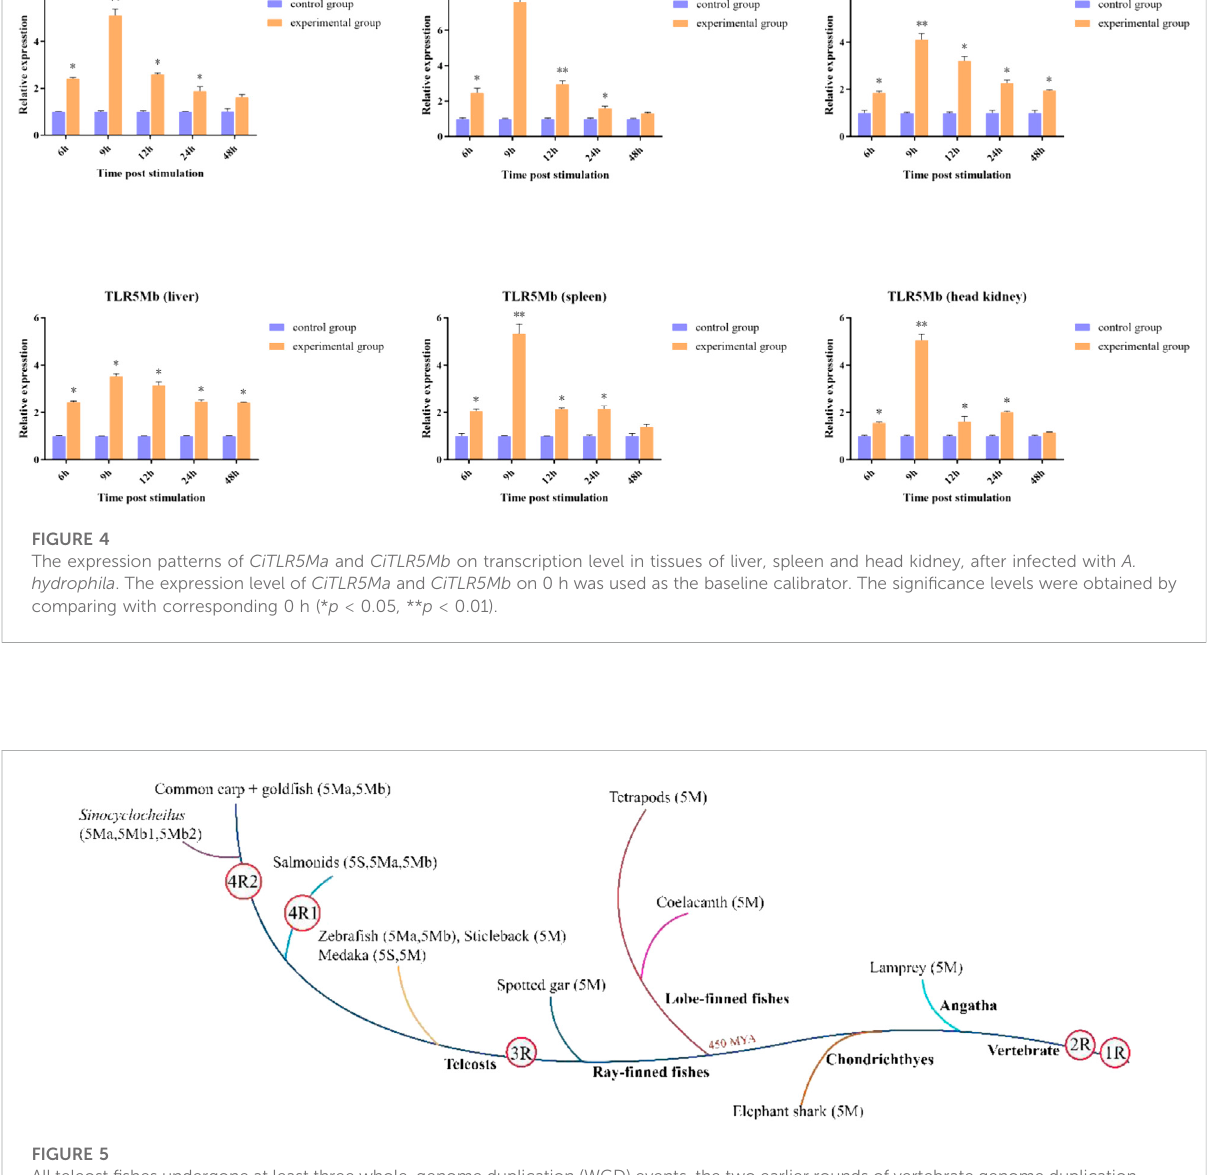
type) demonstrated neofunctionalization to sense viral dsRNA as functional homodimeric receptors in antagonistic effect (Liao et al., 2022). Domain number variation was identi fi ed in the fi sh TLR5 isotypes, generating functional diversity and complexity (Asami and